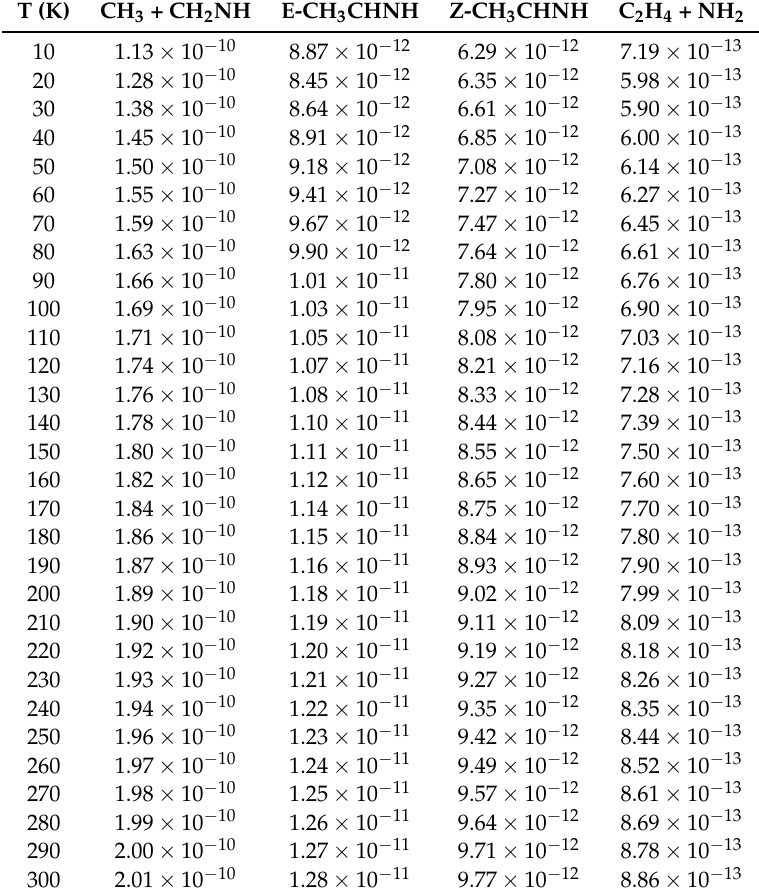
Table 2. Product-formation rate constants (in cm 3 molecule − 1 s − 1 ) at 1 the temperature.